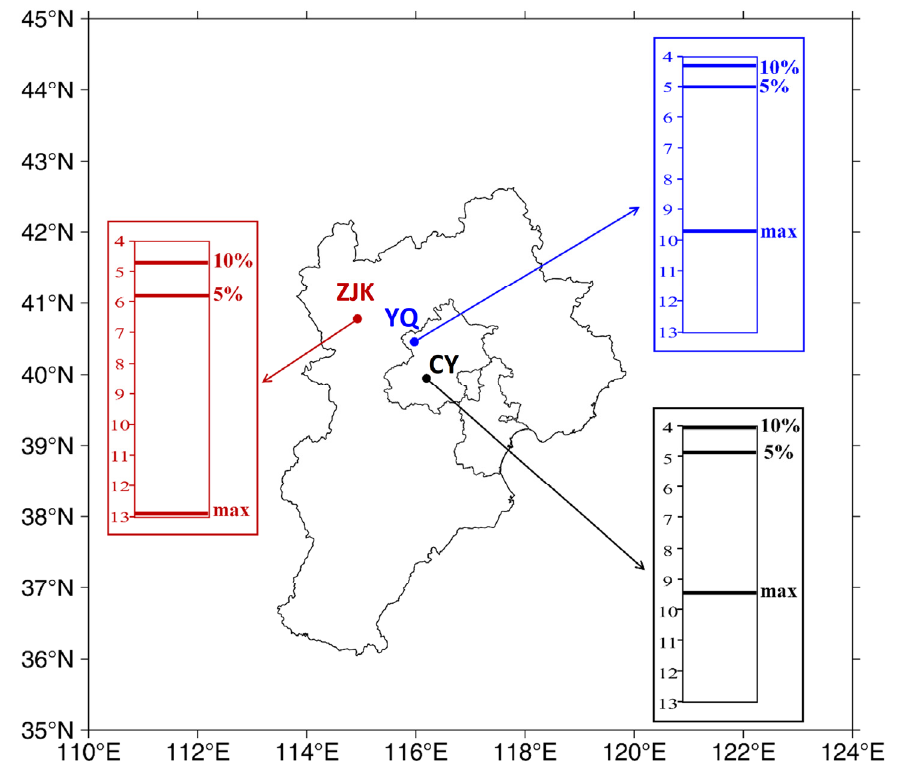
Figure 1. The maximum, the fifth and 10th percentiles of temperature drops (unit: ◦ C) for extreme cold surges (ECSs) (noted as 5%) and CS (10%) events at Chaoyang (abbreviated to “CY”), Yanqing (“YQ”) and Zhangjiakou (“ZJK”).